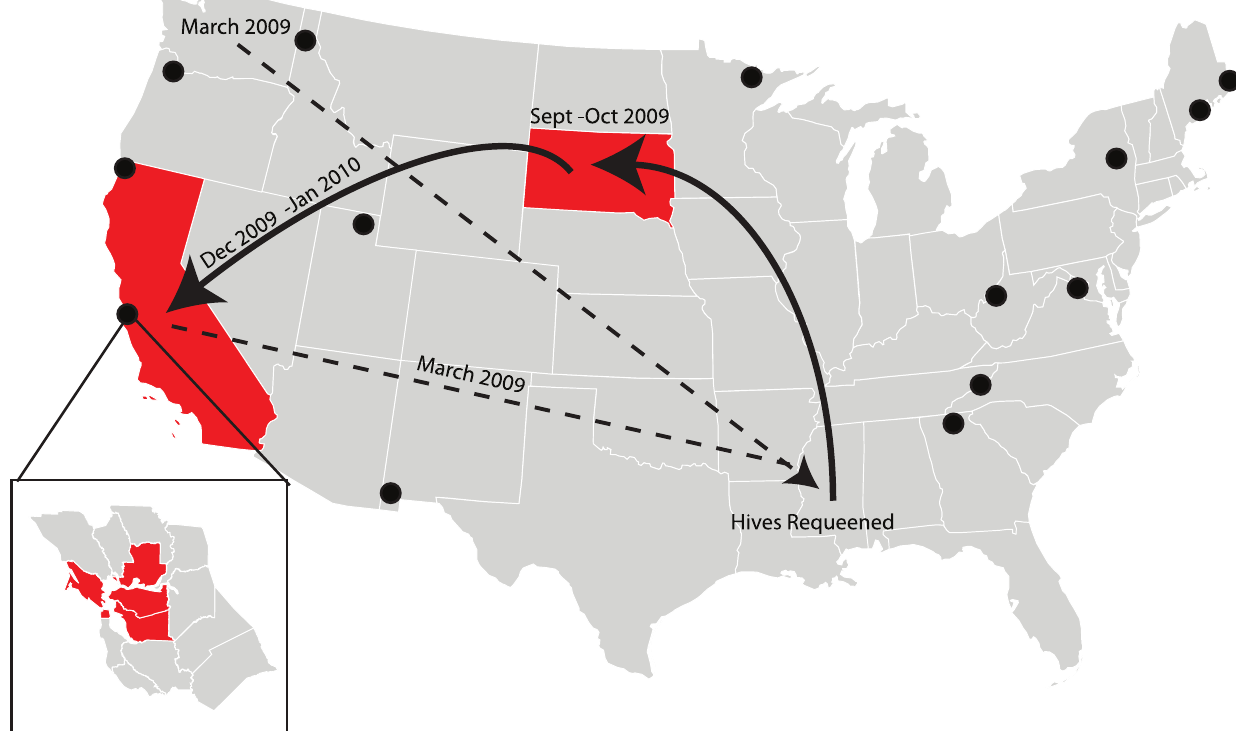
Figure 1. Distribution of phorid-infected honey bees sampled in this study (red). Inset shows the San Francisco Bay Area counties where we found phorid-parasitized honey bees. The routes of commercial hives tested are indicated (arrows), where dotted lines represent states the hives crossed before viral microarray testing and solid lines represent the route of hives during the period of microarray testing. Sites where A. borealis was previously known [7] are indicated by black dots.